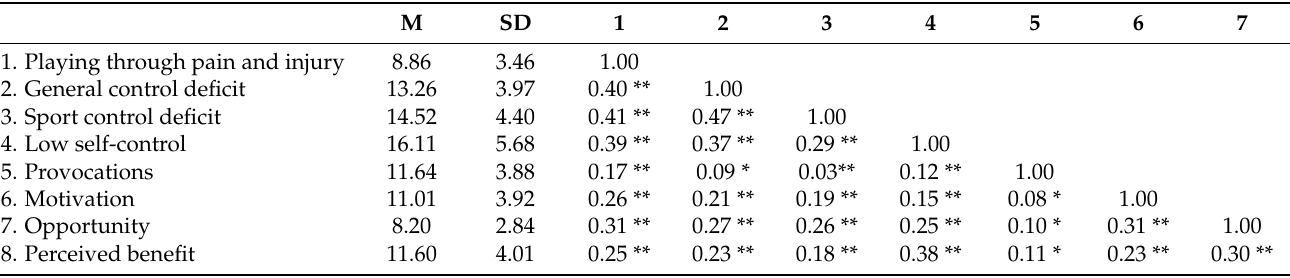
Table 2. Zero-order correlations between independent and dependent variables ( n = 749). M